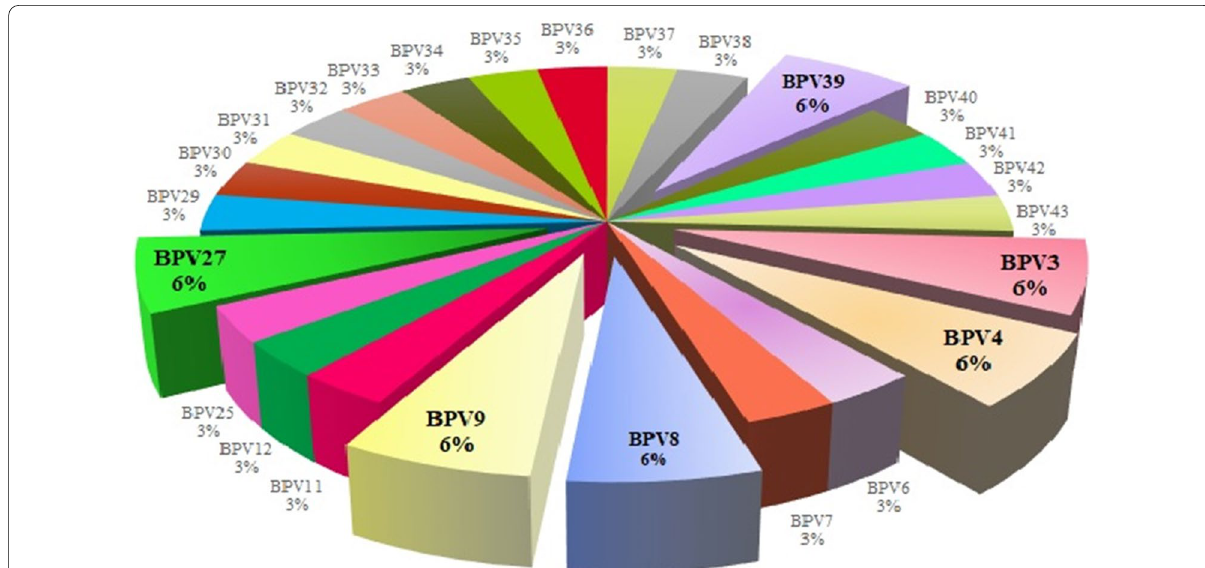
Fig. 3 Frequency of different BPV types in the samples of this study. The graphic depicts the frequency of classical BPV types and new BPV types detected in the 16 samples with BPV-related contigs. BPV3, BPV4, BPV8, BPV9, BPV27 and the new BPV type named BPV39 were the most frequent types found in sequences greater than 350